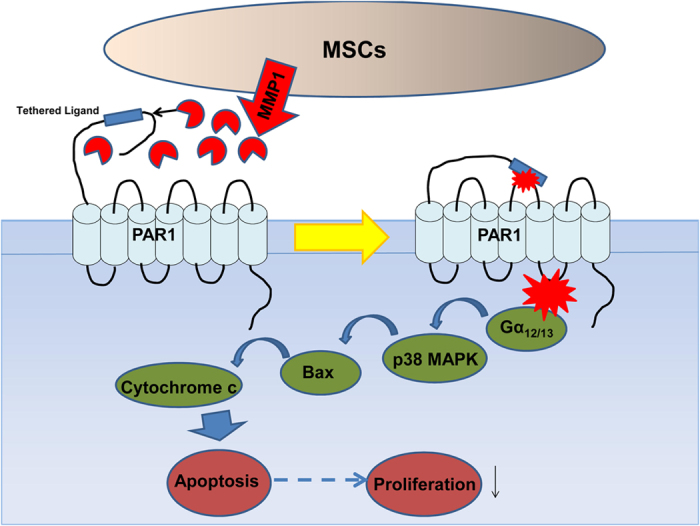
Model of MMP1/PAR1 interaction and subsequent activation of p38 MAPK signalling.MMP1 which is secreted by MSCs binds to and cleaves the extracellular N terminus of PAR1 to release a tethered ligand. Upon binding to the second extracellular loop, the ligand activates intracellular G proteins (Gα12/13) across the membrane and initiates activation of the p38 MAPK pathway, including the translocation of Bax and release of cytochrome c from the mitochondria, resulting in apoptosis and growth suppression. Therefore, downregulation of MMP1 in MDS-MSCs leads to reduced apoptosis resulting in increased MDS cell proliferation.